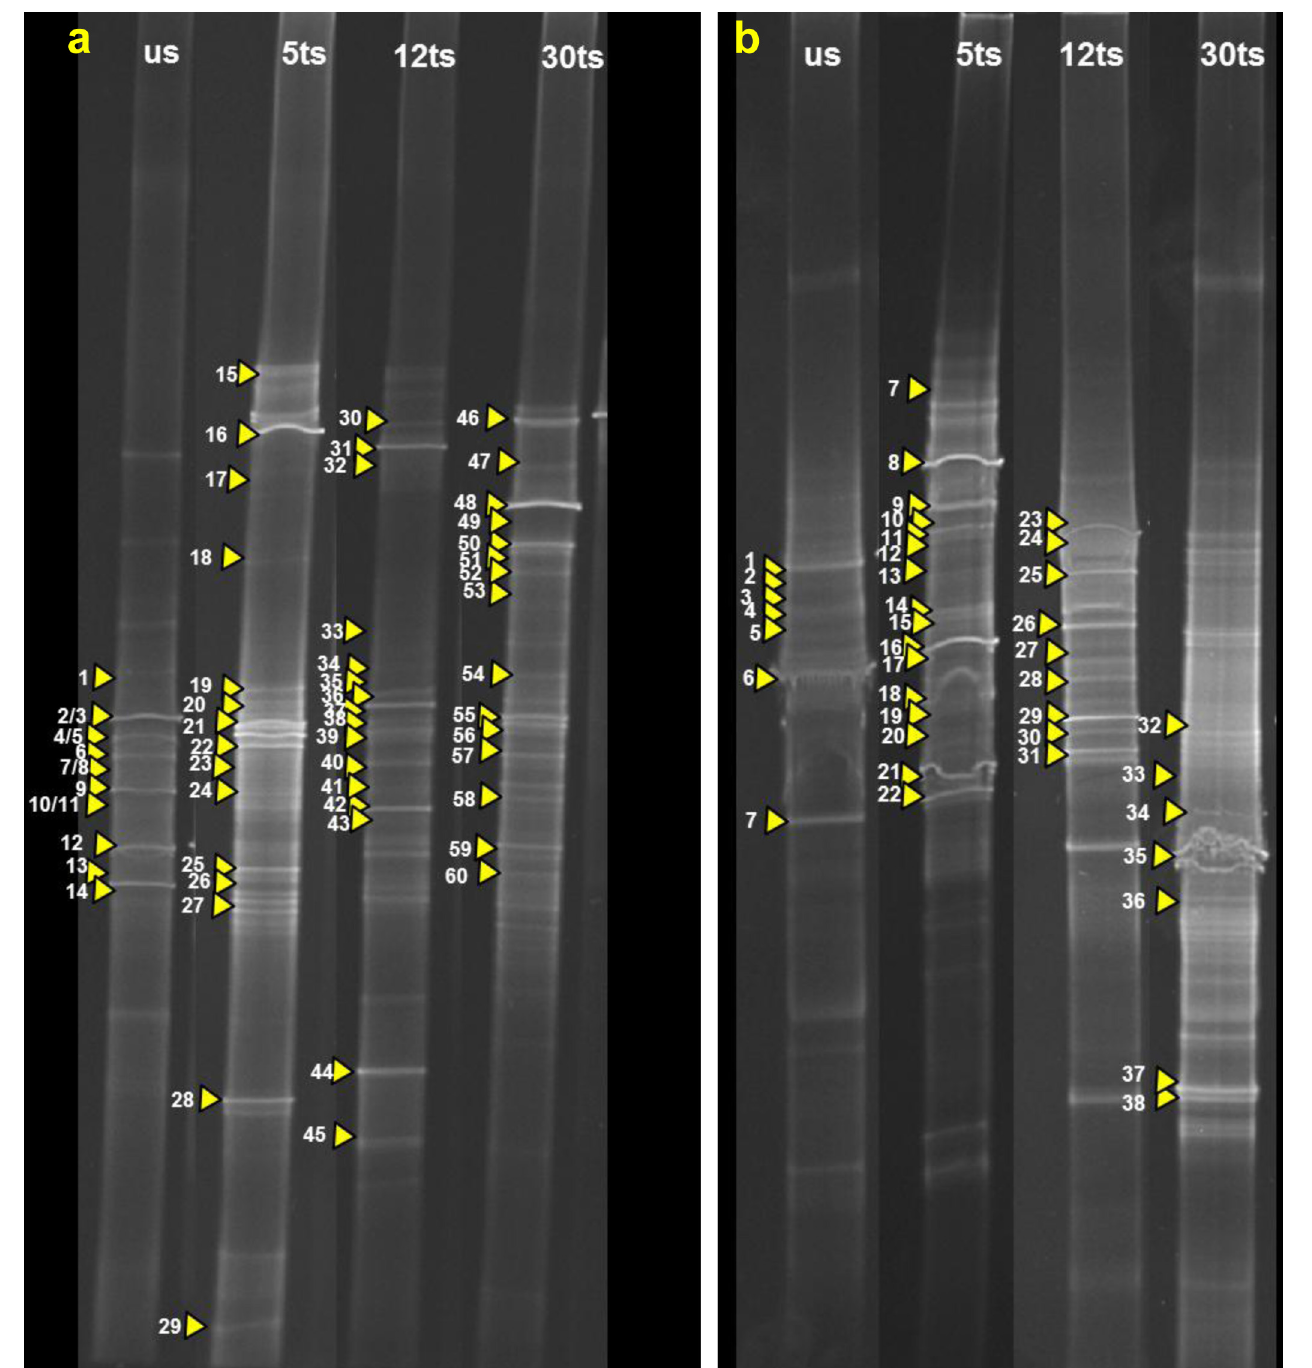
Fig 2. DGGE profiles derived from the a) bacterial and b) fungal communities colonizing the stonework of the Royal Chapel showing the succession in the microbial community structure and the monitoring along the time course. us corresponds to untreated stone and 5ts, 12ts, and 30ts correlate to the different sampling times after the application of the bio-consolidation treatment: after five, twelve, and thirty months, respectively. Dominant, faint- and in the DGGE profile of the original sample sometimes not visible bands, identified from clone libraries, were numbered and marked with arrowheads. The bands are explained in the Tables 1 and